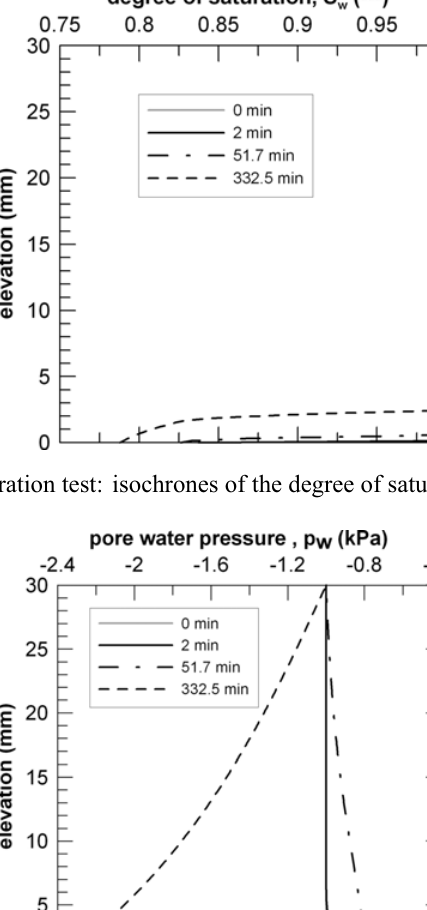
Fig. 8 – Electrokinetic filtration test: isochrones of pore water pressure computed for